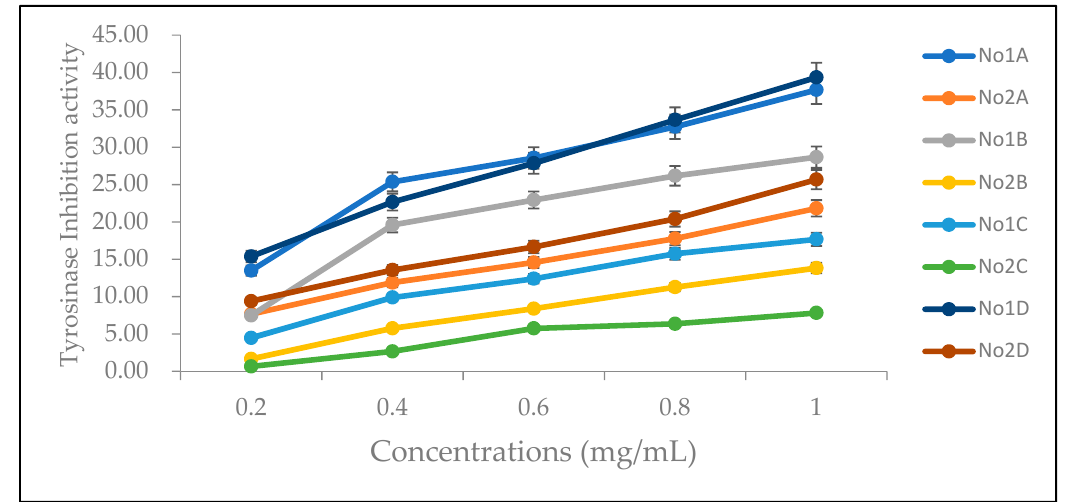
Figure 2. Tyrosinase inhibitory activities of No. 1 and No. 2 extracted with different solvents. No. 1A and No. 2A are ethanol extracts, No. 1B and No. 2B are ethyl acetate extracts, No. 1C and No. 2C are n-hexane extracts, and No. 1D and No. 2D are pure-water extracts. Table 4. Comparisons of the tyrosinase-inhibitory activities of the four solvent extracts of the two varieties of Hang Ju. Extract Number No. 1A Extract Number Tyrosinase inhibitory activity (%) a–d Values (mean ± SD, n = 3 for all test groups) in the same row not sharing the same alphabetic letter are significantly different ( p < 0.05). No. 2 in comparison with No. 1 sample, p < 0.001